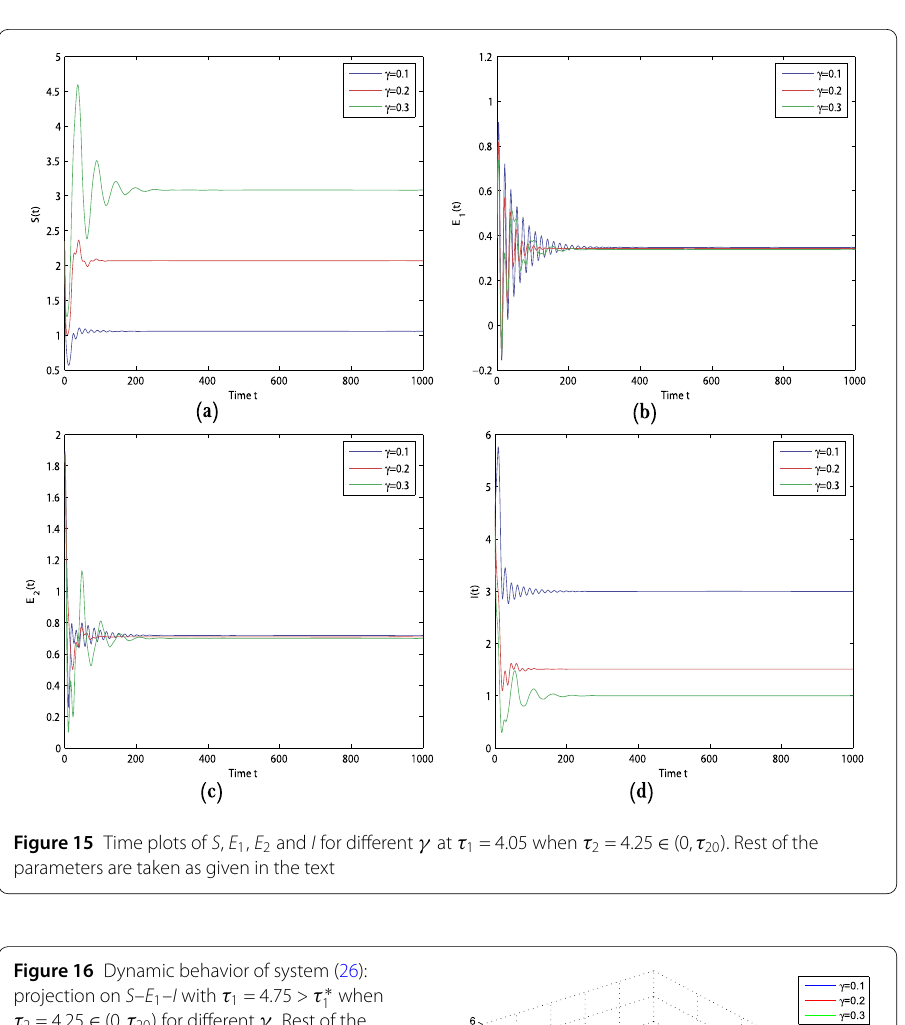
Figure 16 Dynamic behavior of system (26): projection on S – E 1 – I with τ 1 = 4.75 > τ ∗ 1 when τ 2 = 4.25 ∈ (0, τ 20 ) for different γ . Rest of the parameters are taken as given in the text